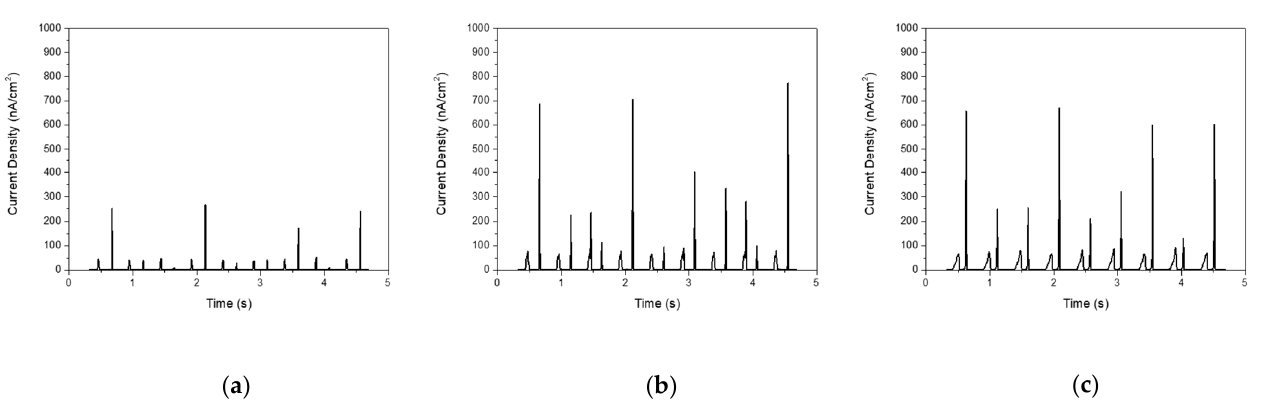
Figure 9. Current density generated from piezoelectric NGs with PDMS layers of various thickness, ( a ) 40, ( b ) 80, ( c ) 100 µ m, on ZNRs with an aspect ratio of 11:1. Table 3. Current density generated from piezoelectric NGs with various thicknesses of PDMS, (a) 40,